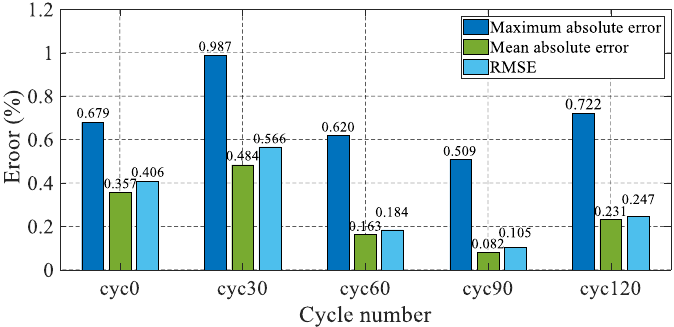
Figure 11. The estimated errors of the SOC corresponding to the aging battery cell.